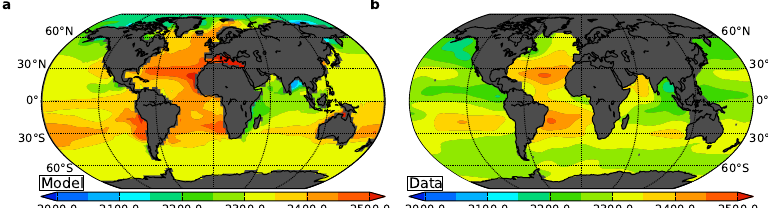
Figure 14. Alkalinity (ALK) distribution at the ocean surface (µmolkg − 1 ). Data from GLODAP (Key et al., 2004).